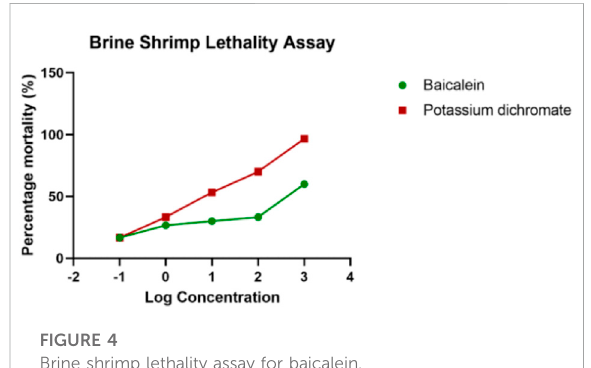
FIGURE 4 Brine shrimp lethality assay for